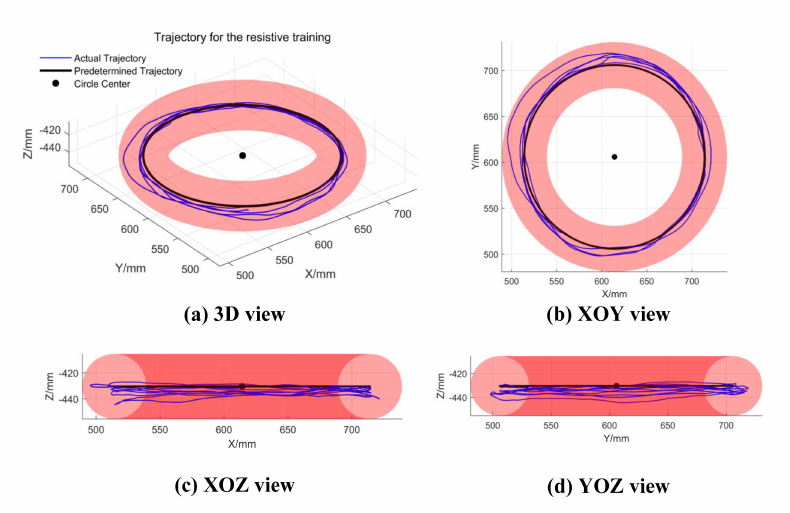
Figure 20. The trajectory of subject’s hand during the resistant testing. ( a ) A 3D view of the trajectory; ( b – d ) XOY, XOZ, and YOZ view of the trajectory, respectively.